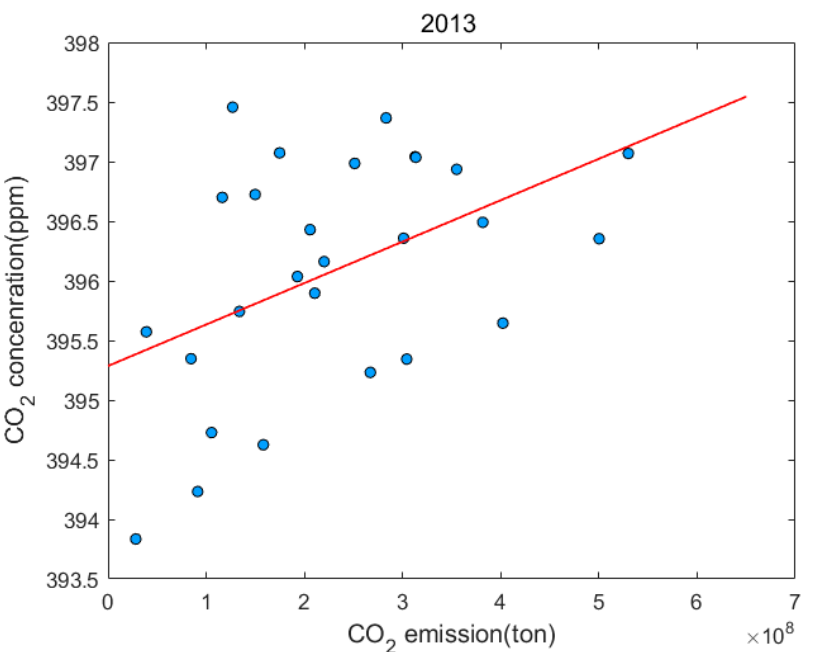
Figure 7. Fitting relationship between carbon emissions and the carbon concentration of Chinese provinces.